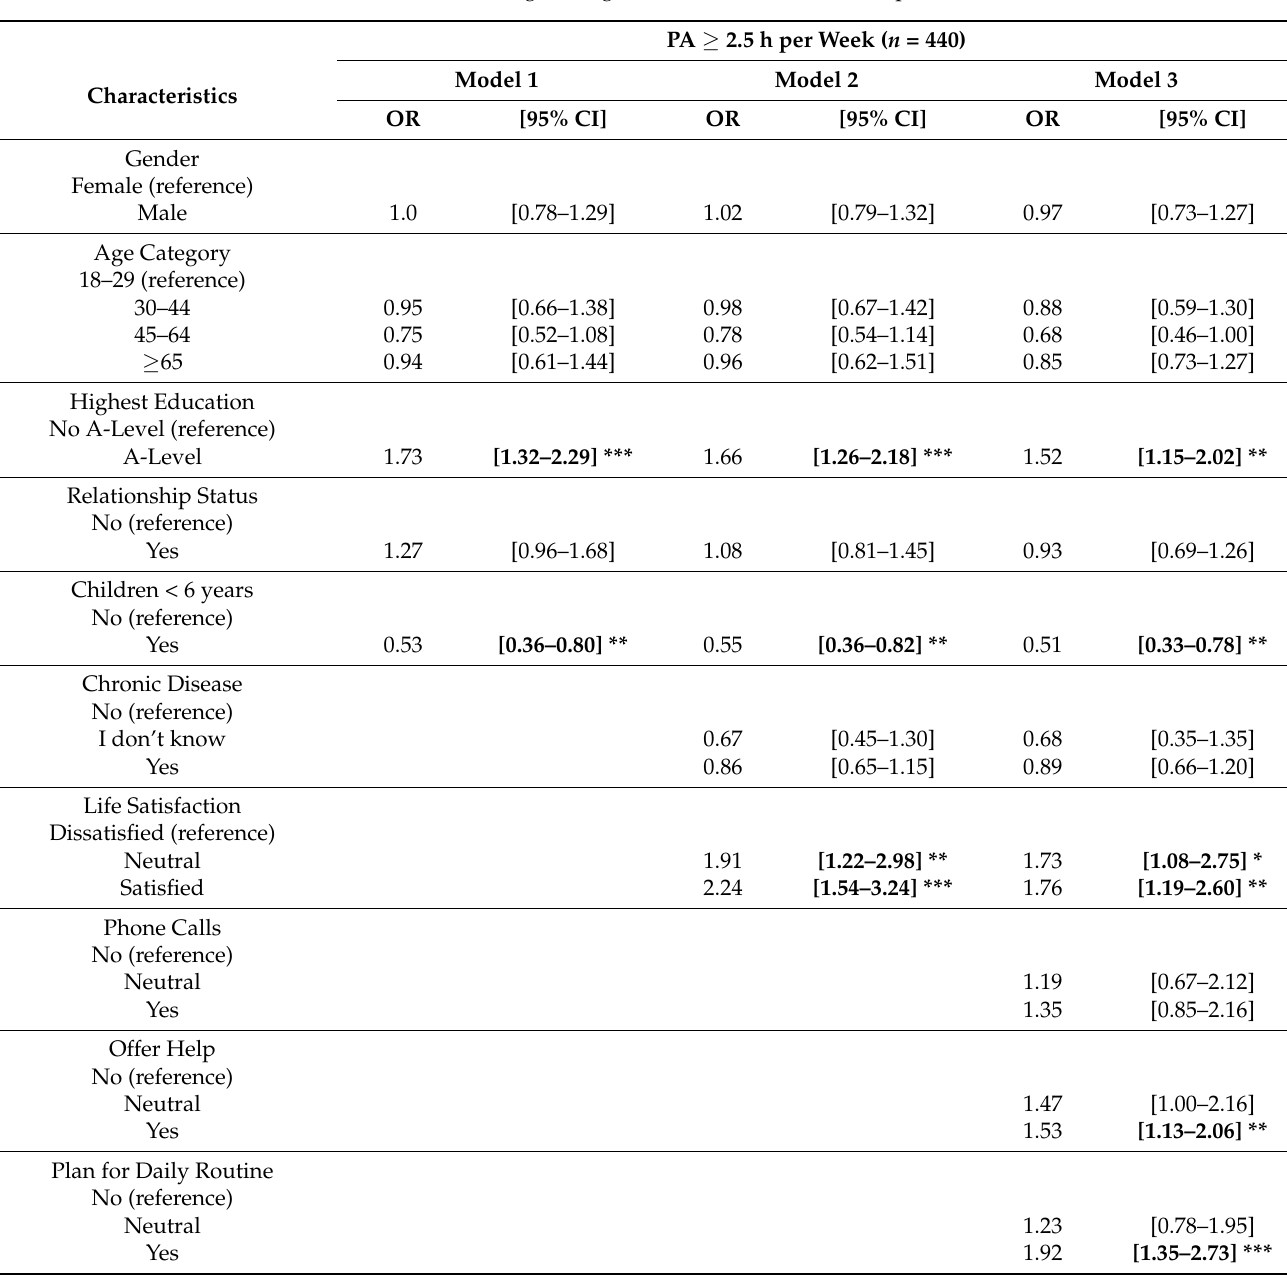
Table 3. Multivariate logistic regression models—PA ≥ 2.5 h per